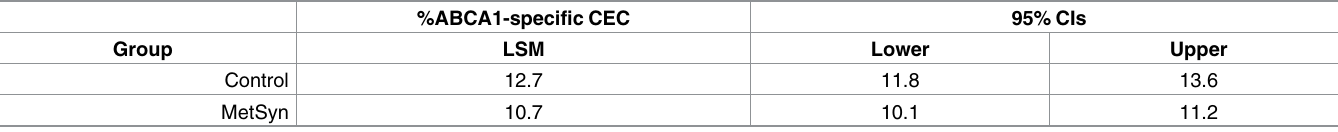
Table 4. Group differences in ABCA1-specific CEC a .